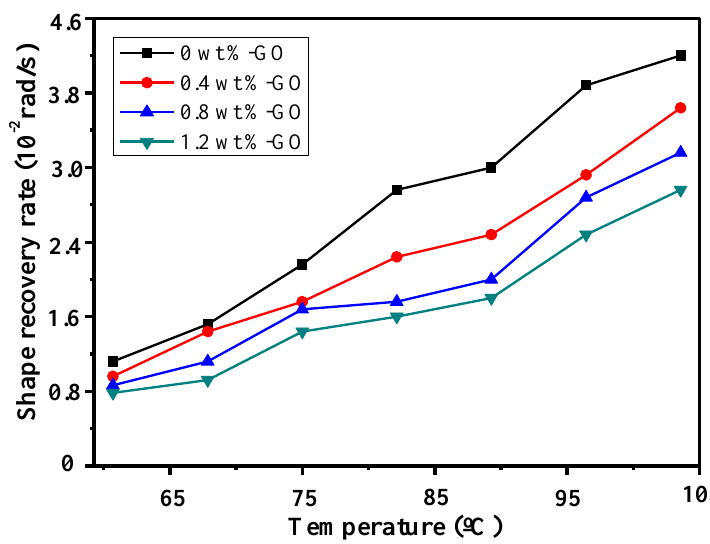
Figure 15. The shape recovery rate of SMEP composites with different GO contents at different temperatures.